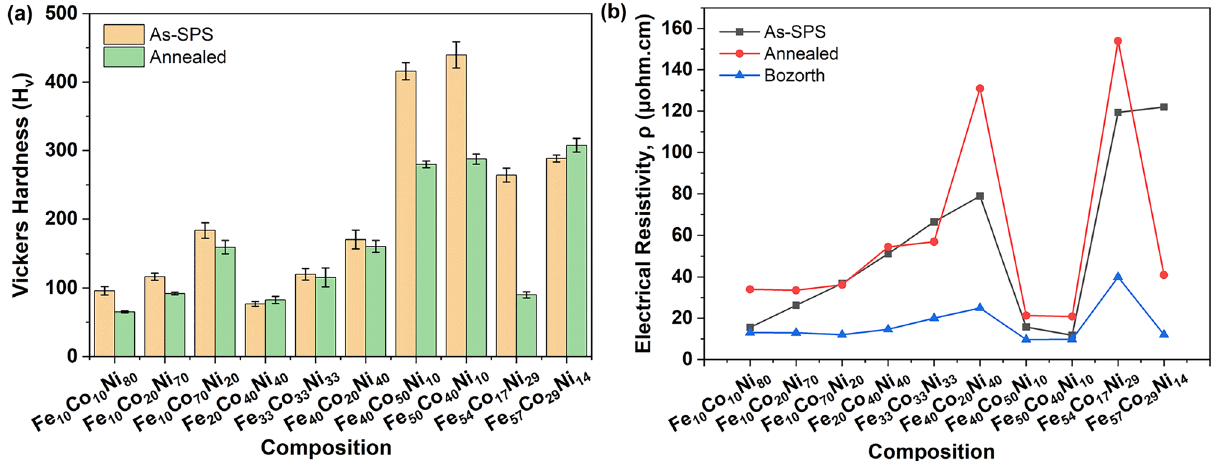
Figure 6. The ( a ) Vickers hardness, H v , and ( b ) electrical resistivity, ρ, of ternary alloys as a function of composition for as-SPS, annealed and reference values 33 .